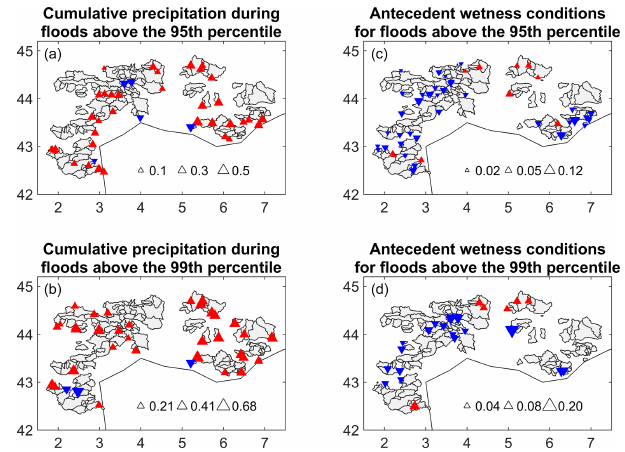
Figure 6. Significant trends at the 10% level (Mann–Kendall test) in cumulative precipitation during flood events above the 95th and 99th percentile (a, b) and in the soil moisture initial condi- tions (c, d) . Blue triangles indicate a decrease and red triangles an increase. The size of the triangles indicates the relative